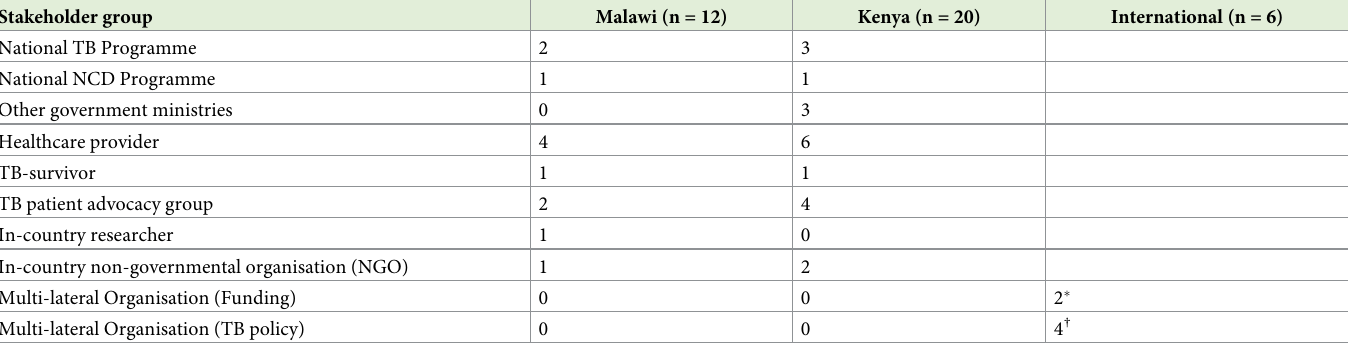
Table 1. Stakeholder